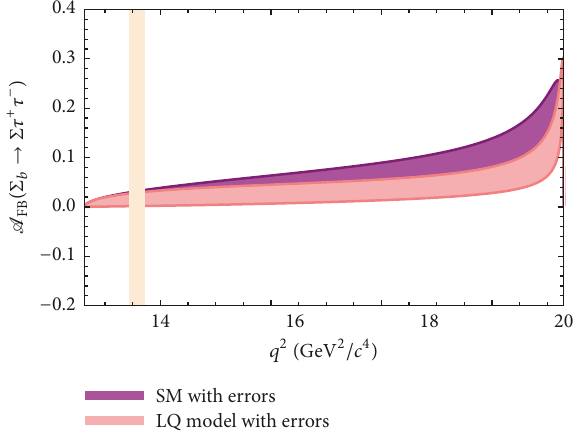
Figure 10: The dependence of A FB on 𝑞 2 for the Σ 𝑏 → Σ𝜏 + 𝜏 −